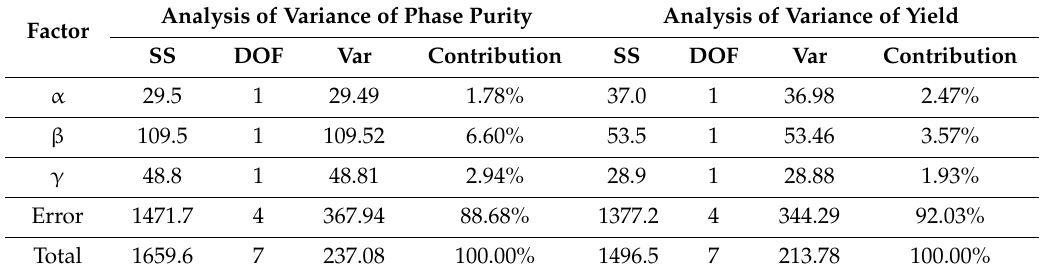
Analysis of variations in phase purity (left) and yield (right) of hydrothermally synthesized smectites.